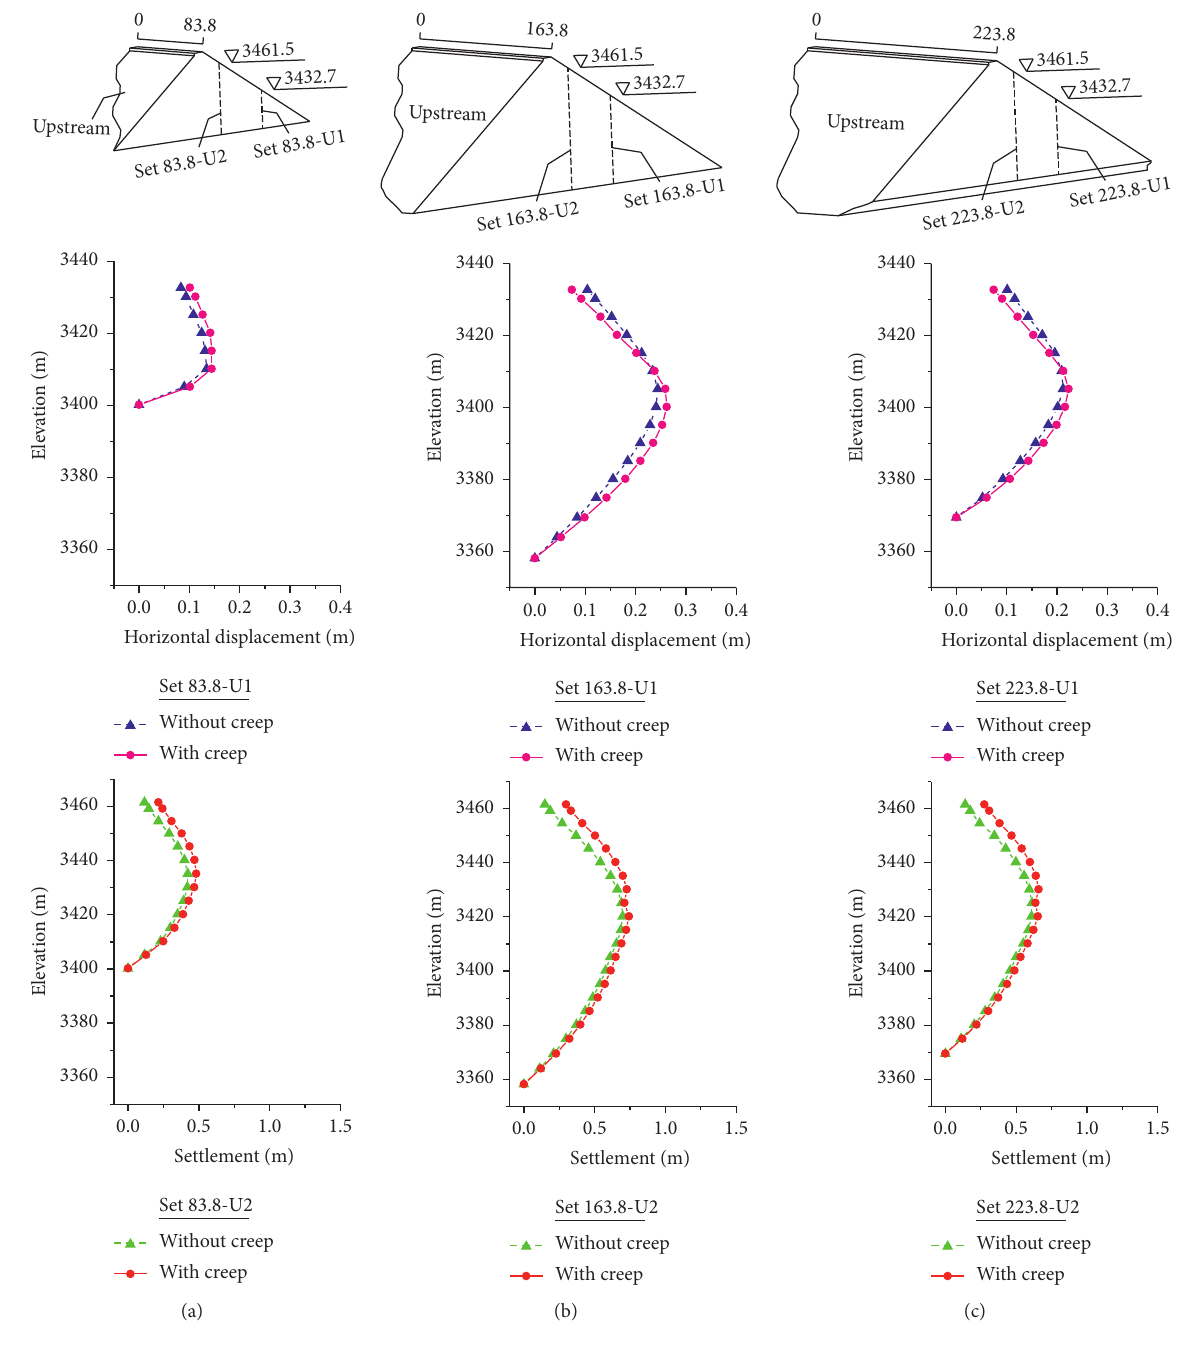
Figure 8: Horizontal displacement and settlement by FEM